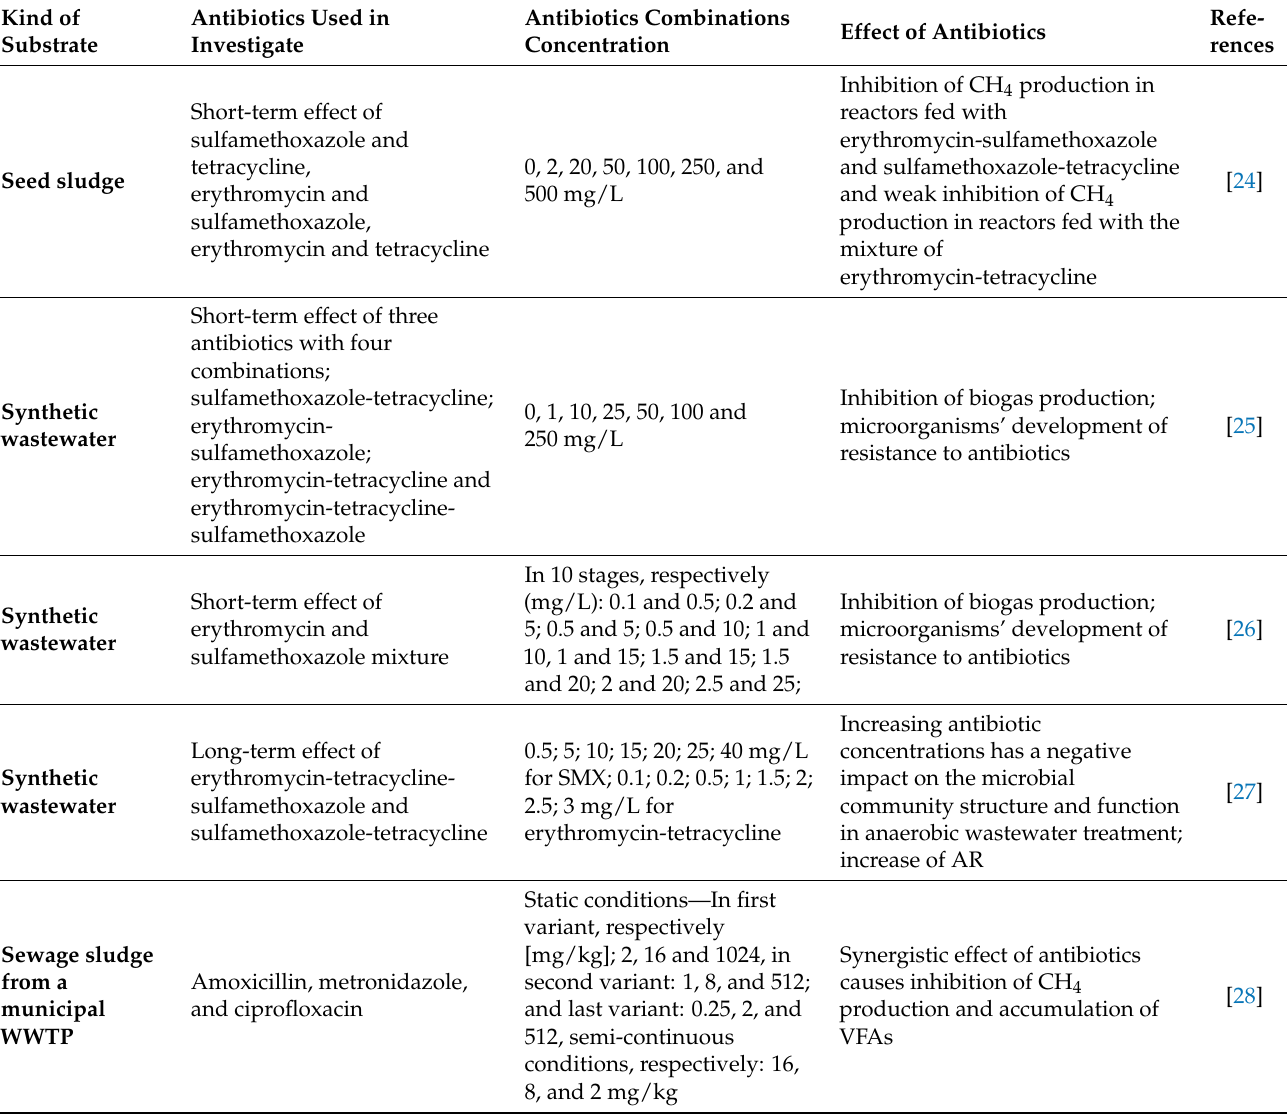
Table 1. The summary of the literature from the last decade, about synergistic effect of drugs on the mesophilic AD